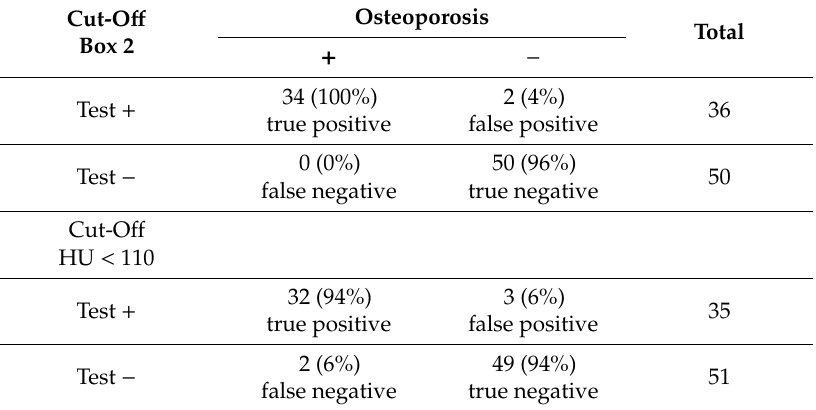
Table 2. Fourfold table for the cut-o ff values “box 2” and “Hounsfield unit (HU) <